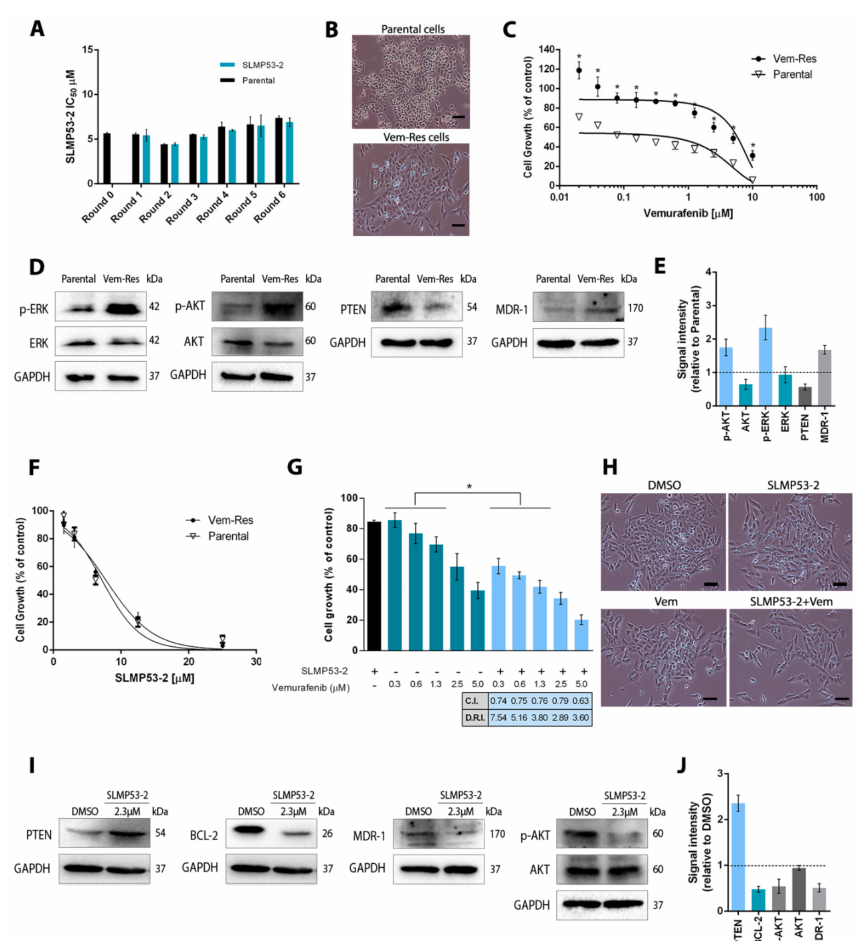
Figure 7. Melanoma cells do not develop resistance to SLMP53-2: vemurafenib-resistant melanoma cells show no cross- resistance to SLMP53-2 and are resensitized to vemurafenib by SLMP53-2. ( A ) A375 cells were exposed to six rounds of treatment with 6, 9, 12, 18, 24 and 30 µ M of SLMP53-2. IC 50 values were determined at the end of each round by SRB assay after 48 h of treatment. Data were normalized to DMSO and correspond to mean ± SEM, n = 5 (two replicates each); values not significantly different from parental cells: p > 0.05, two-way ANOVA followed by Sidak’s test. ( B ) Representative images of parental, vemurafenib-resistant (Vem-res) A375 cells; scale bar = 100 µ m; magnification = 100 × . ( C ) Concentration– response curves for vemurafenib in parental and Vem-res A375 cells after 48 h of treatment. Data were normalized to DMSO and correspond to mean ± SEM, n = 6 (two replicates each); values of Vem-res cells significantly different from parental cells: * p < 0.05; two-way ANOVA followed by Sidak’s test. ( D , E ) Protein levels of p-AKT/AKT, p-ERK/ERK, PTEN and MDR-1 in untreated parental and Vem-res A375 cells. In D, immunoblots are representative of five independent experiments; GAPDH was used as loading control. In E, quantification of protein expression levels is shown; values with DMSO were set as 1; data are mean ± SEM, n = 5. ( F ) Concentration–response curves for SLMP53-2 in parental and Vem-res A375 cells after 48 h of treatment. Data were normalized to DMSO and correspond to mean ± SEM, n = 6 (two replicates each); values of Vem-res cells are not significantly different from parental cells: two-way ANOVA followed by Sidak’s test. ( G ) Vem-res A375 cells were treated with a concentration range of vemurafenib alone and in combination with 2 µ M of SLMP53-2. Cell growth was evaluated for 48 h of treatment; growth obtained with DMSO was set as 100%. For each combination, the C.I. and D.R.I. values were obtained. Data are mean ± SEM, n = 6 (two replicates each); values are significantly different from vemurafenib alone: * p < 0.05, two-way ANOVA followed by Sidak’s test. ( H ) Representative images of Vem-res A375 cells treated with DMSO, 2 µ M SLMP53-2, 1.3 µ M vemurafenib (Vem) and the combination (SLMP53-2 + Vem) for 48 h; images are representative of five treatments; scale bar = 100 µ m; magnificatio n = 100 × . ( I , J ) Protein levels of PTEN, BCL-2, MDR-1 and p-AKT/AKT, in Vem-res cells after 48 h of treatment with 2 µ M SLMP53-2. In I, immunoblots are representative of five independent experiments; GAPDH was used as loading control. In J, quantification of protein expression levels is shown; values with DMSO were set as 1; data are mean ± SEM, n =